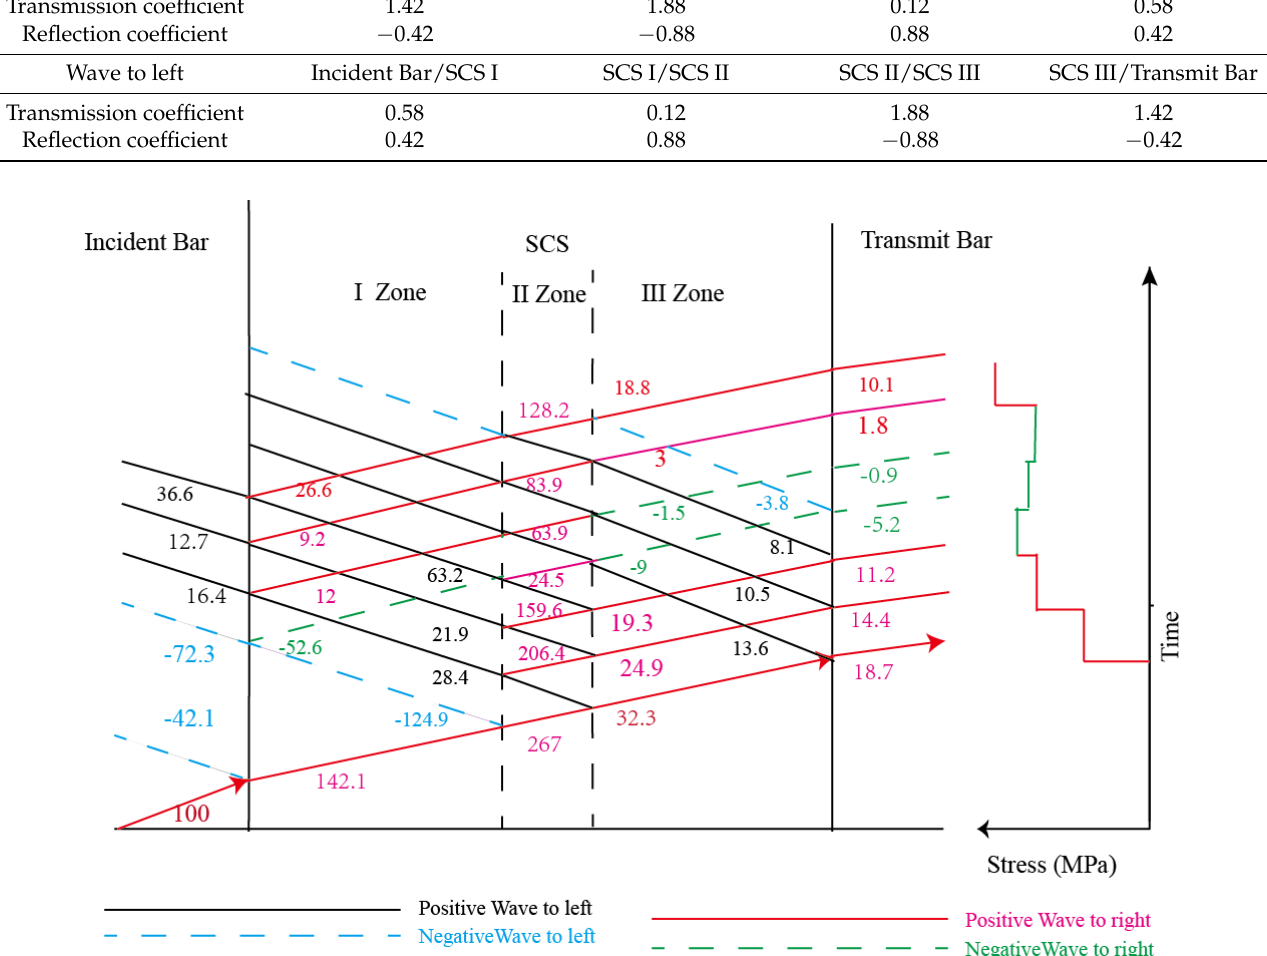
Figure 8. Stress wave propagation based on stress wave theory.